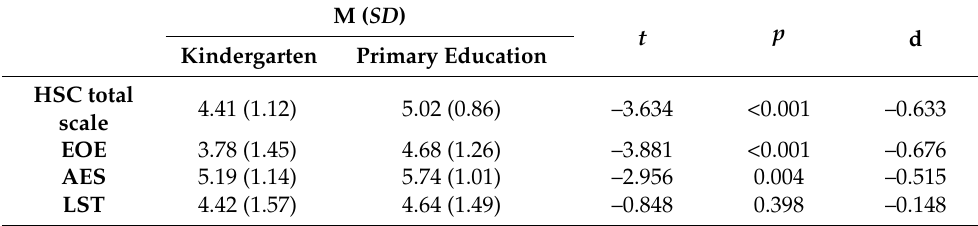
Table 7. Differences between kindergarten and primary level education regarding the environmental sensitivity in